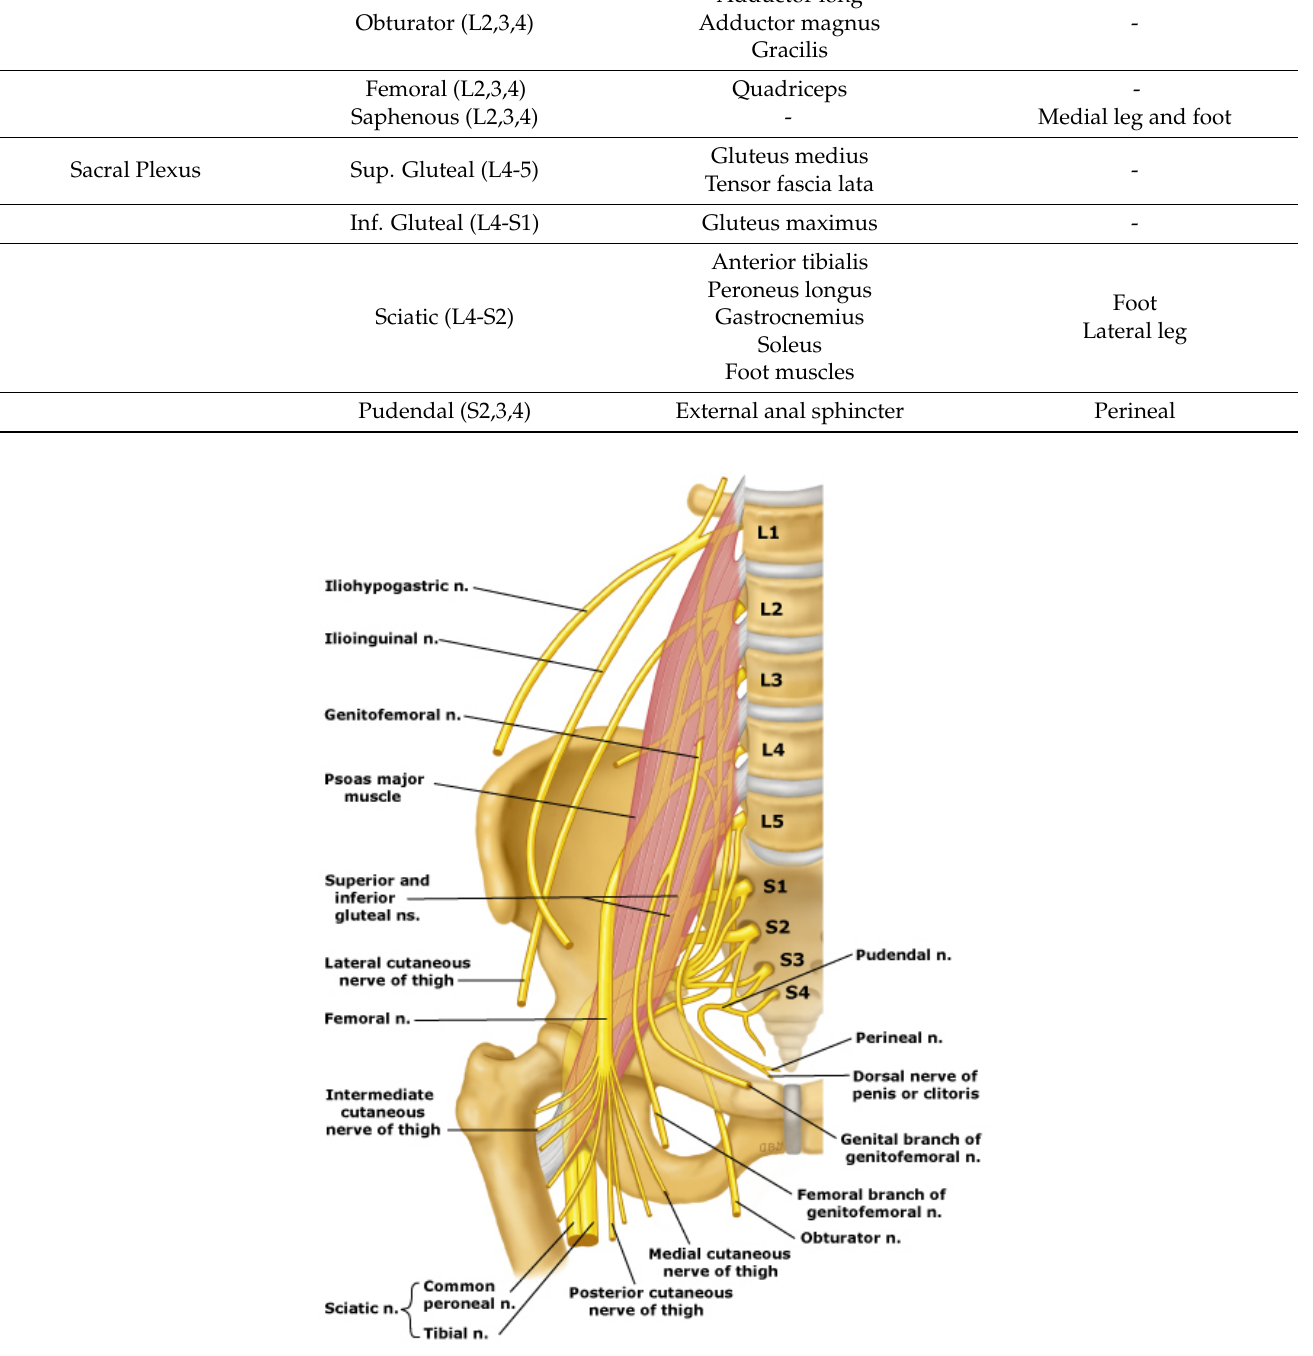
Figure 3. Anatomy of the Lumbosacral Plexus. Coronal view of the lumbosacral plexus and its branches [19].